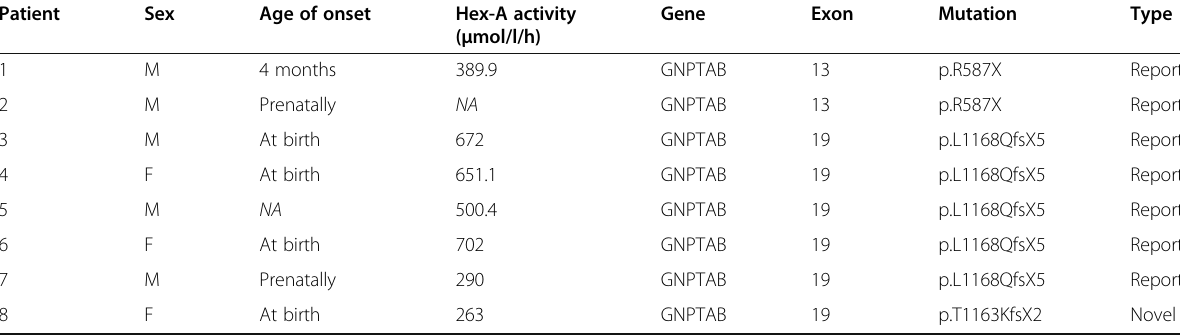
Table 2 Biochemical and molecular results in the 8 studied patients